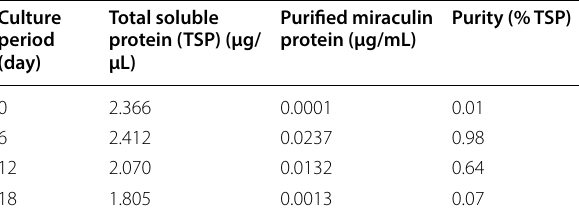
Table 1 Concentration of miraculin protein extracted from transgenic callus cultured in an air-lift bioreactor Culture